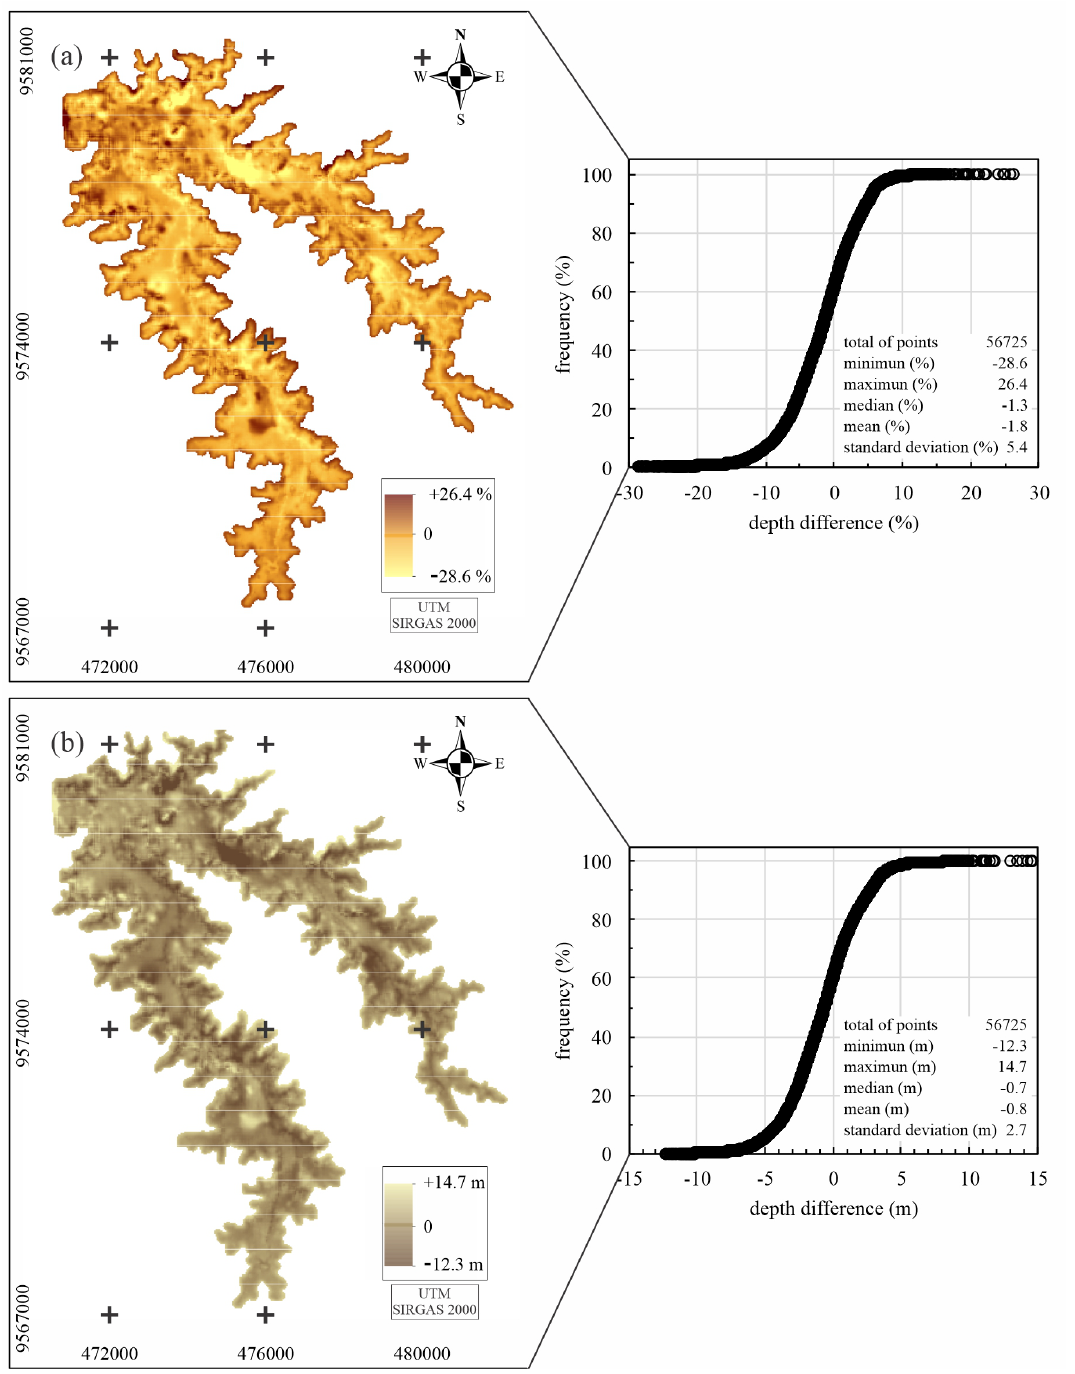
Figure 9. Differences in the topography of the Pentecoste reservoir due to survey methods: CBS (Conventional bathymetric survey) and BRS (Bathymetric survey using Remote Sensing simplified method): ( a ) differences in depths in % [(CBS − BRS)/CBS] and the respective frequency curve; and ( b ) differences in depths in meters (CBS − BRS) and the respective frequency